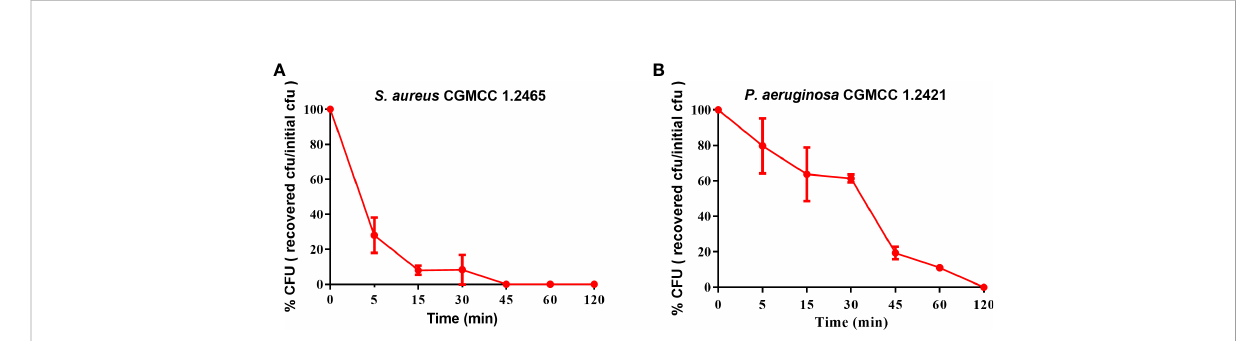
FIGURE 3 Time-killing curves of Spgillcin 177 – 189 on S. aureus and P. aeruginosa . (A) Time-killing curve of Spgillcin 177 – 189 on S. aureus . (B) Time-killing curve of Spgillcin 177 – 189 on P. aeruginosa .